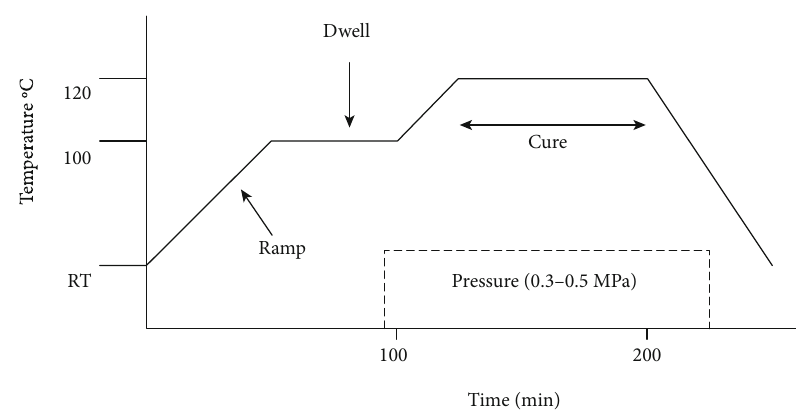
Figure 4: Curing pro fi le of composite structures in